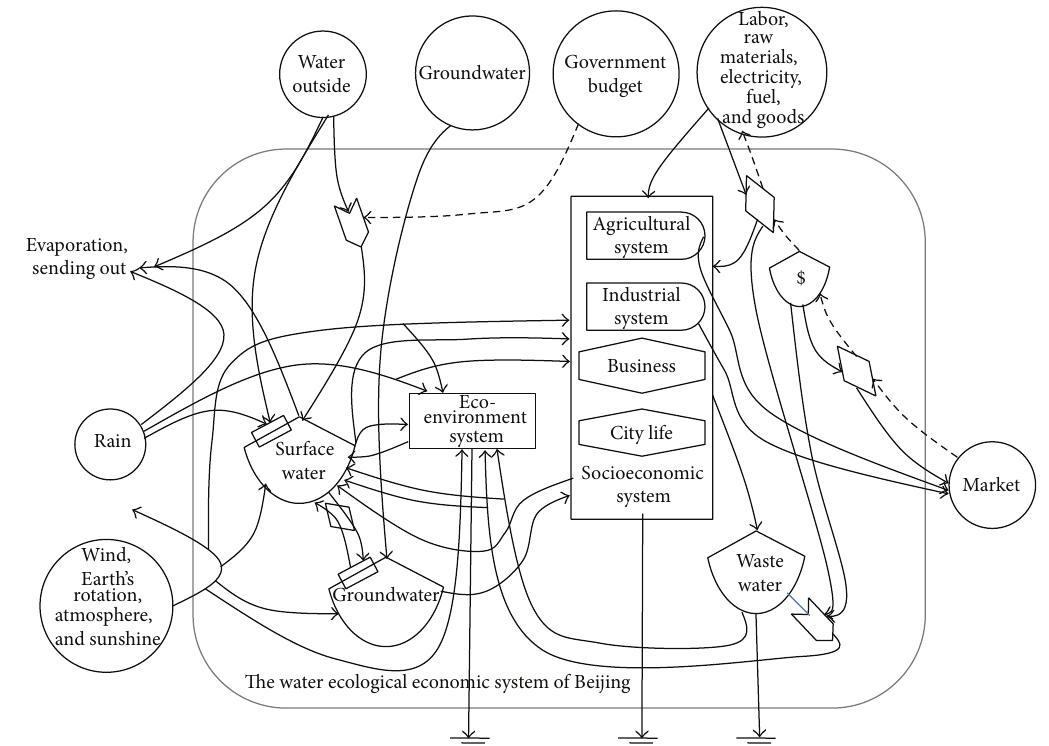
Figure 1: Diagram of eco-economic inputs and outputs within and outside the RWEES (regional water ecological-economic system)